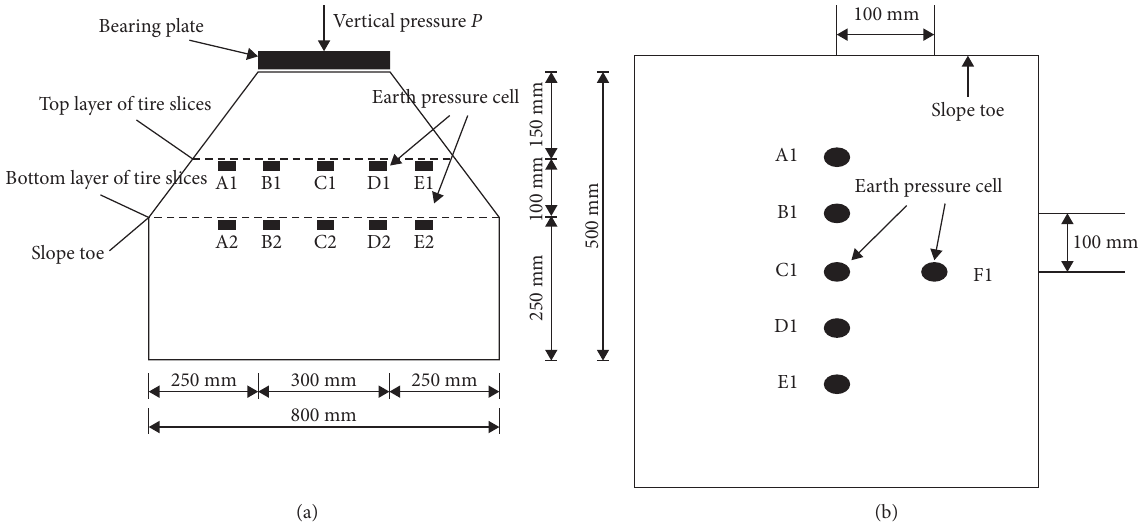
Figure 6: Layout of Earth pressure cells placement. (a) Section view. (b) Plan view.